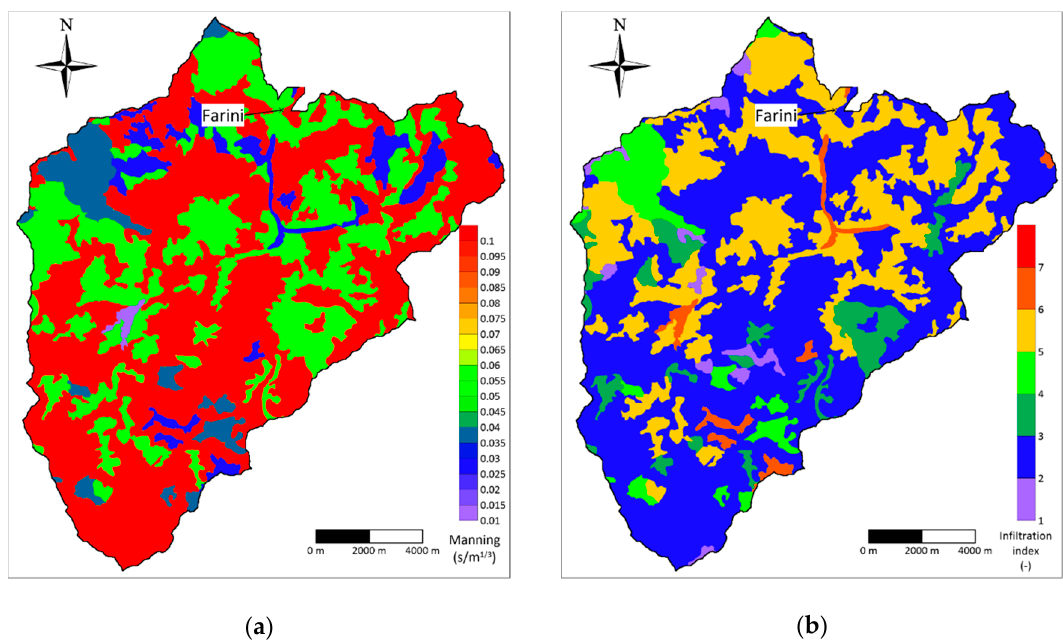
Figure 13. Maps obtained from soil type and land use: ( a ) Manning’s roughness map; ( b ) infiltration index map.